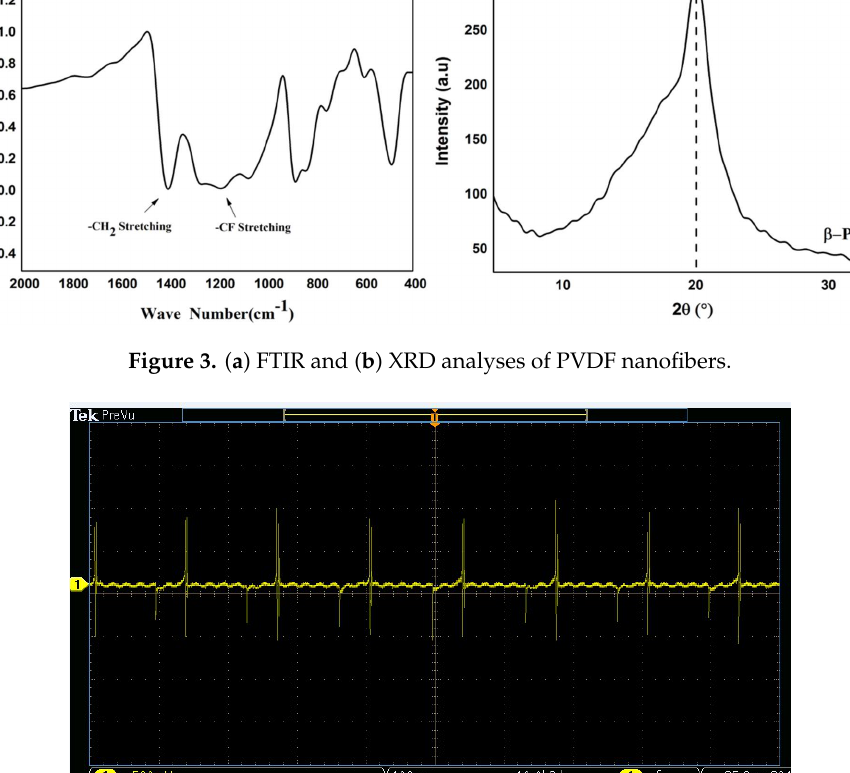
Figure 3. ( a ) FTIR and ( b ) XRD analyses of PVDF nanofibers.